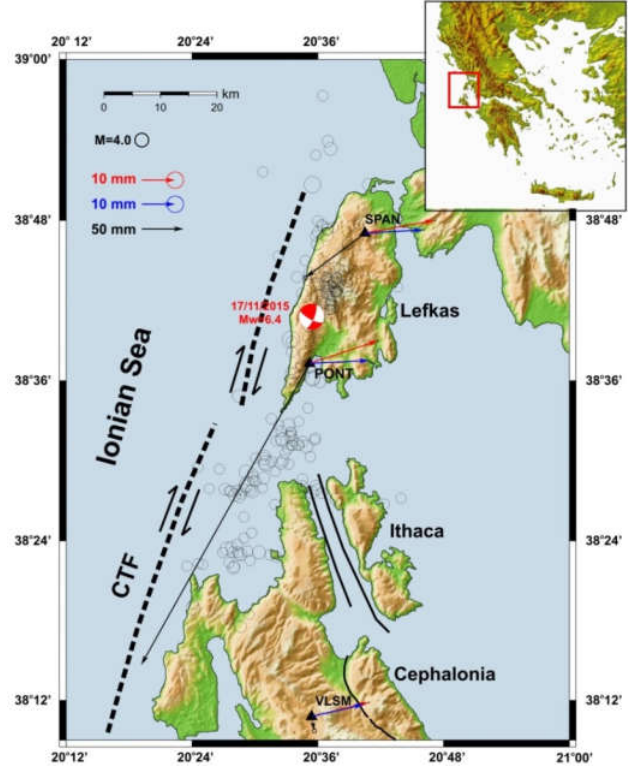
Figure 3. Map of the central Ionian islands of Lefkas, Cephalonia, and Ithaca, showing the main faulting zones and marking the continuous GNSS stations (triangles) PONT and SPAN in Lefkas and VLSM in Cephalonia islands. Circles represent the earthquake epicenters (M > 3) after the 17 November 2015 main event. Red and blue vectors represent the cGNSS horizontal velocities before and after the 2015 earthquake, respectively. Black arrows show the co-seismic deformation. CTF: Cephalonia Transform Fault.